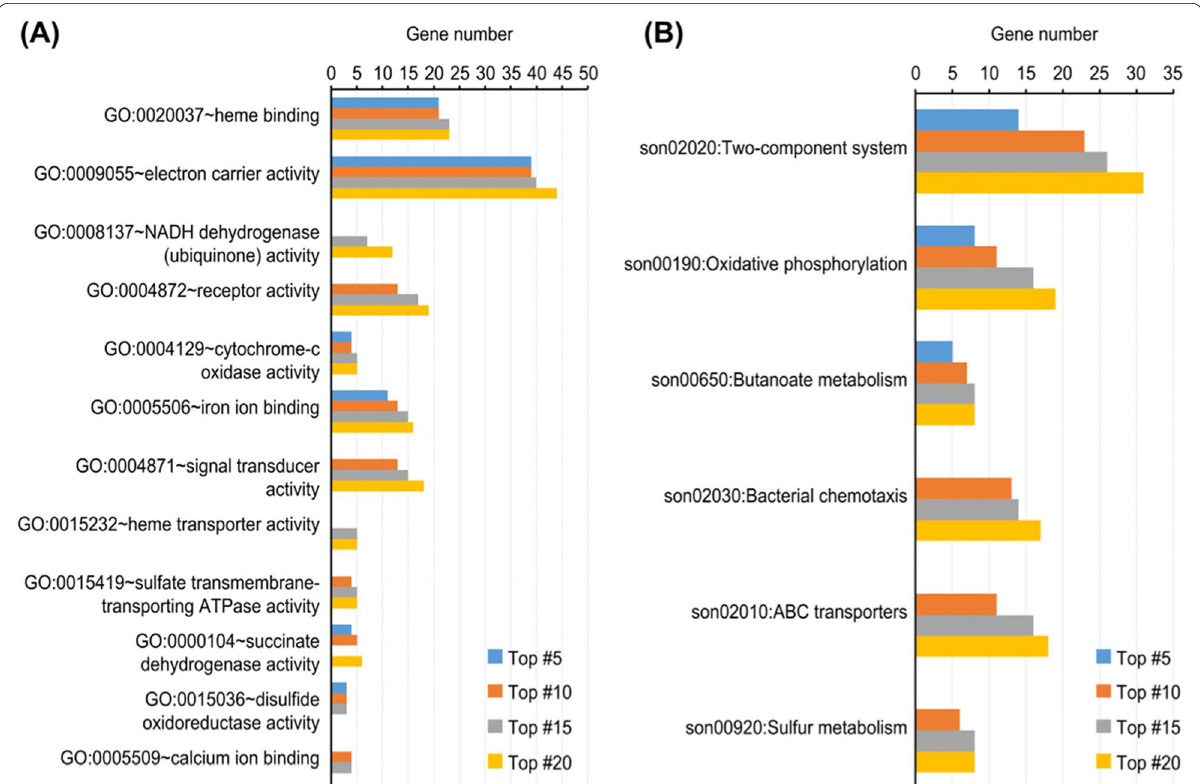
Fig. 1 Enrichments for the co‑fitness genes for all 41 c ‑type cytochromes. A Molecular function enrichment and B KEGG pathway enrichment. Note: the corrected p ‑value < 0.05 (Benjamini